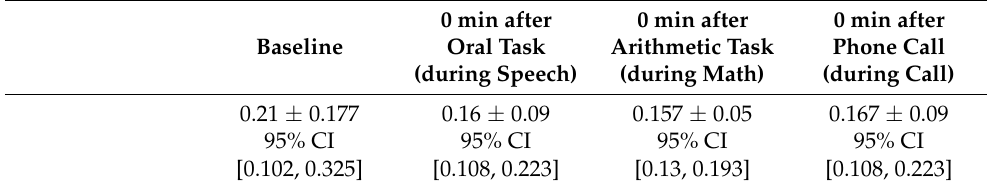
Table 3. Salivary cortisol levels ( μ g/dl) during exposure in the whole population (mean±SD, Confi- dence Intervals, CI, 95%) (n = 20).